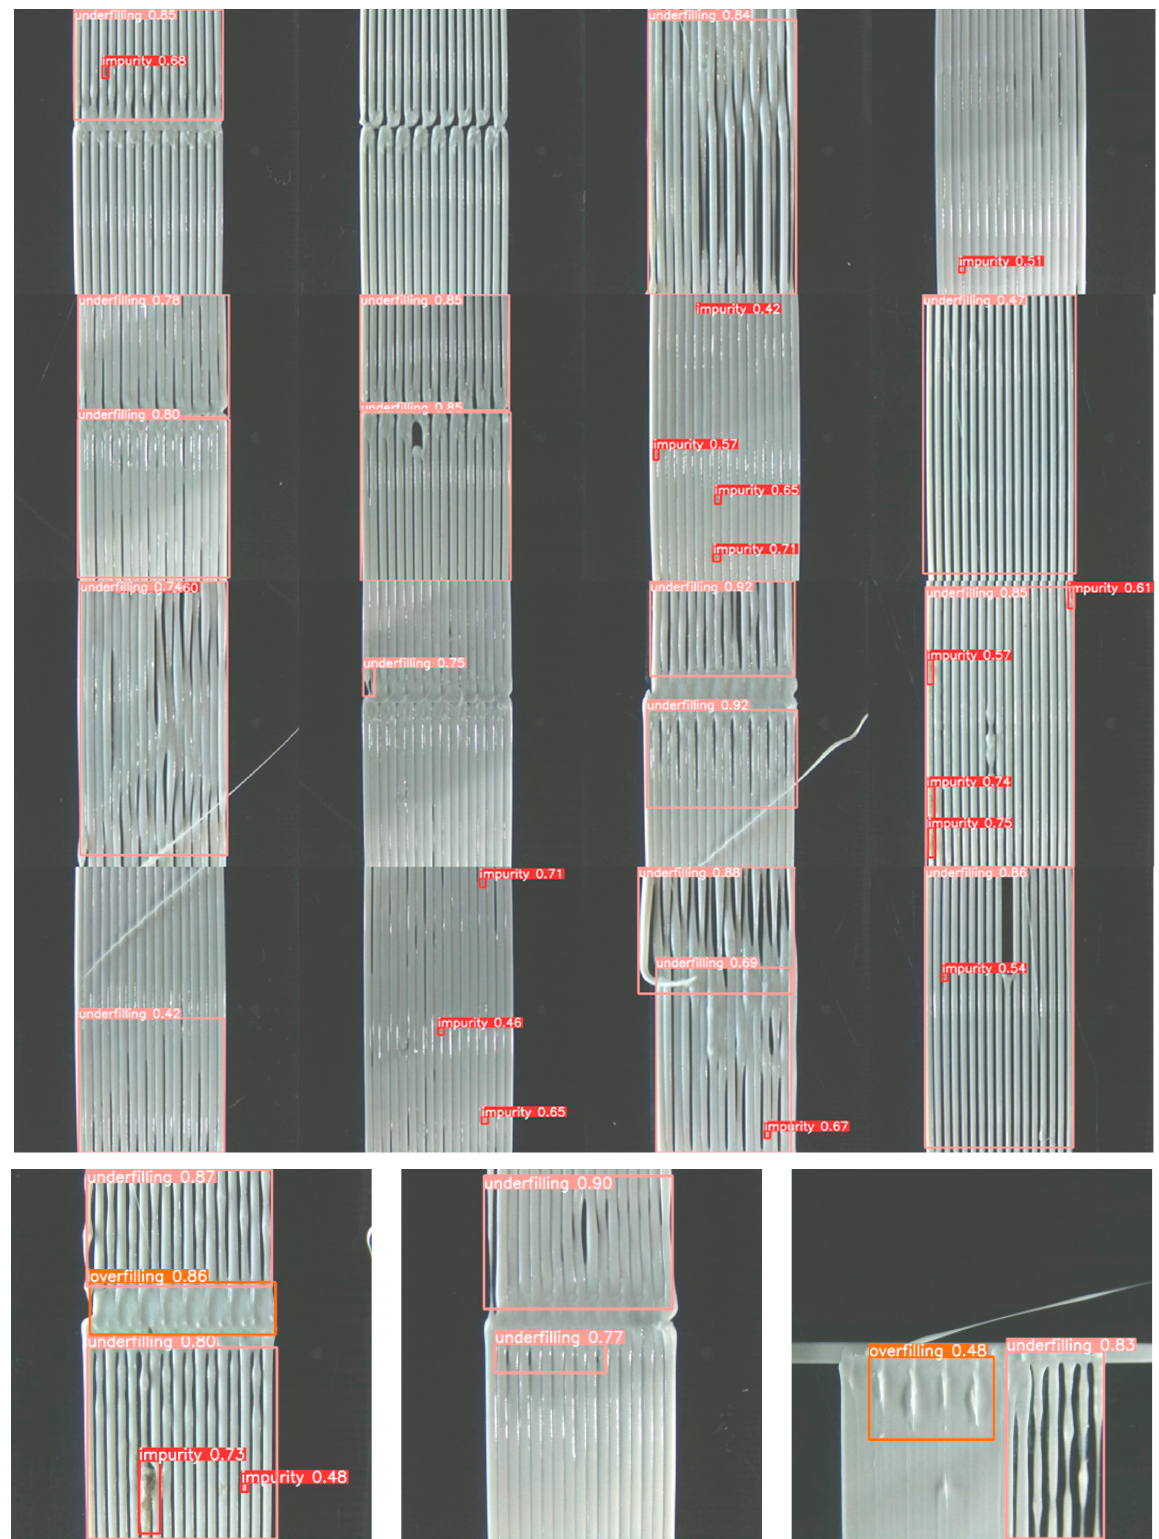
Figure 9. Predicted ( up )defects on 16 blocks of interest, ( down ) defects on three blocks of interest. Table 6. Result table that outlines defects and their relative position on the x ‐ y grid.